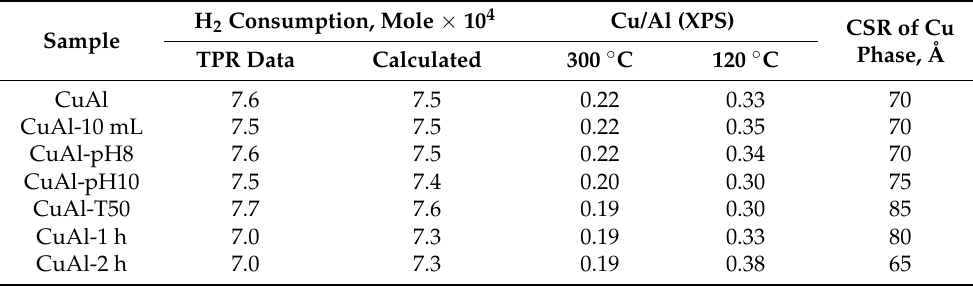
Table 3. H 2 -TPR, XPS and coherent scattering region of the reduced